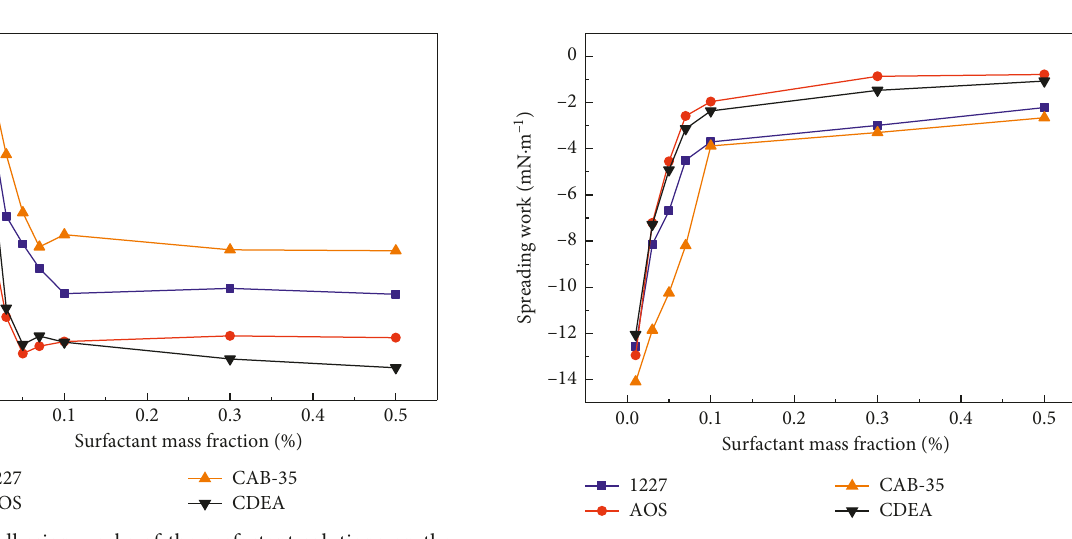
Figure 8. The immersion works of the four surfactants on the